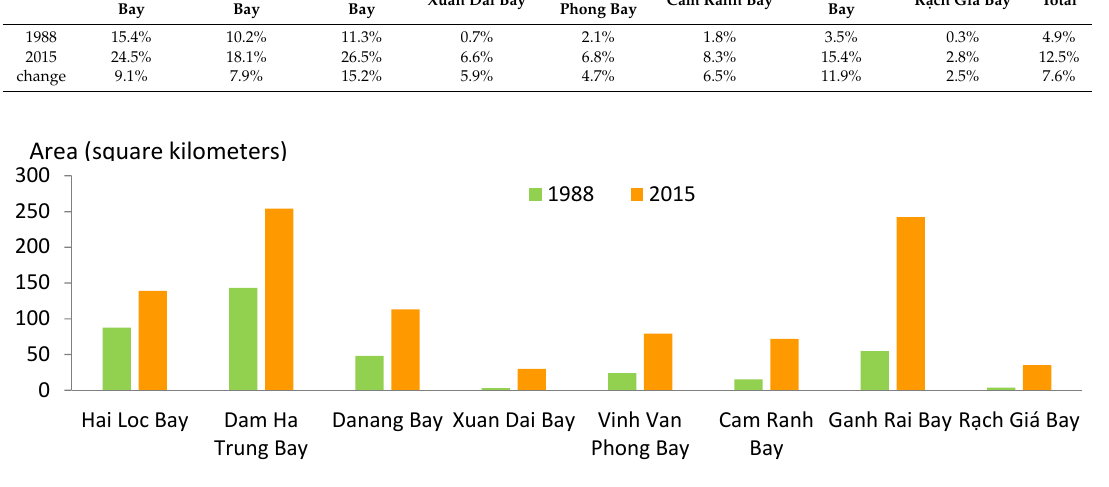
Figure 4. Areas of construction land in bays in 1988 and 2015.